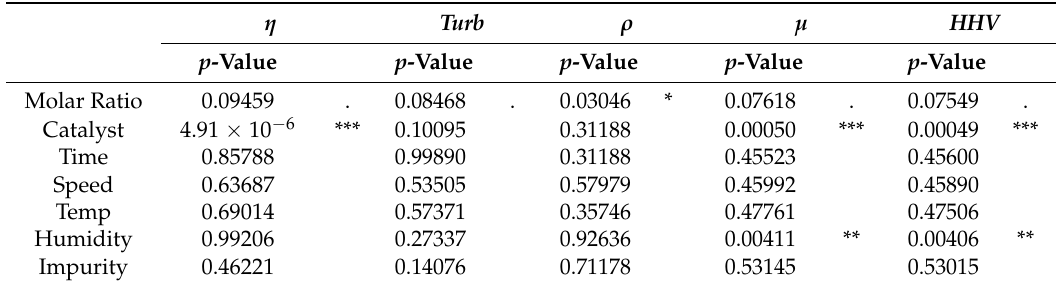
Table 5. Results of the analysis of the variance of the five output